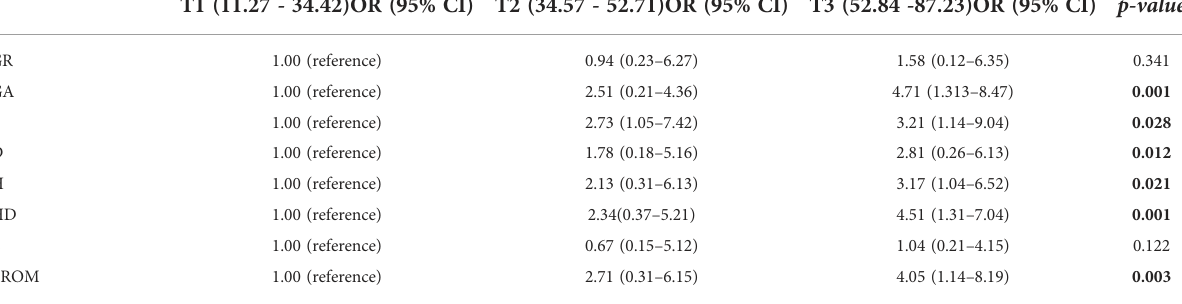
TABLE 5 Association of serum NGAL levels with the risk of adverse pregnancy outcomes. Adverse pregnancy outcomes